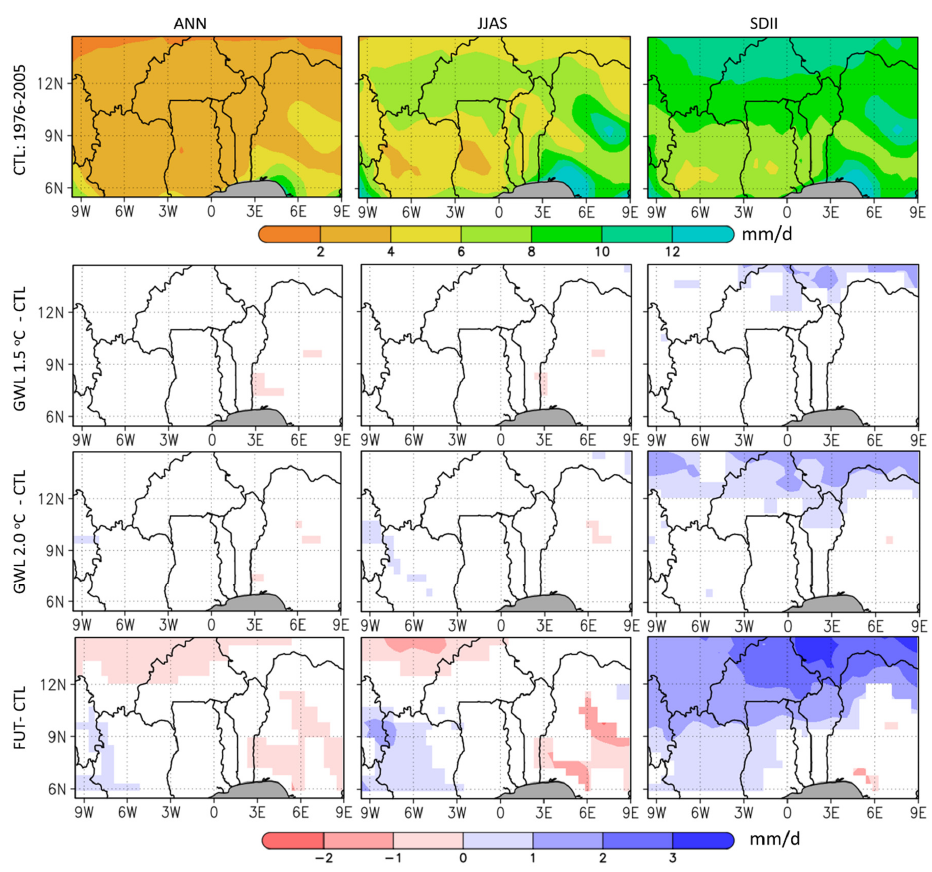
Figure 2. Future precipitation changes for ANN, JJAS, and SDII (at 95% confidence level) for GWL1.5, GWL2.0, and future (FUT) relative to the control period (CTL), under the RCP 8.5 scenario. Areas with no significant changes are shown in white while water bodies are shown in grey.